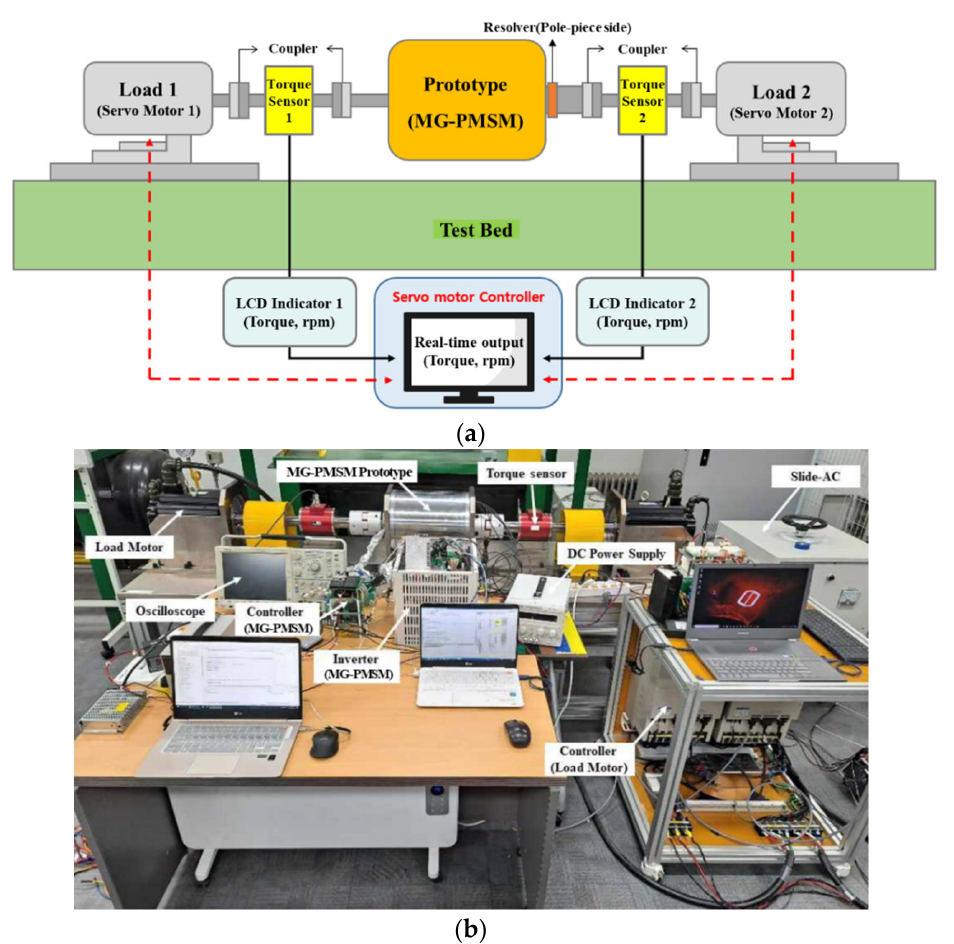
Figure 15. Setup of dual load performance tester and peripheral devices for measuring the driving characteristics of 4.5kW ‐ class MG ‐ PMSM prototype. ( a ) Schematic block diagram related to measurement setup; ( b ) Measurement set.